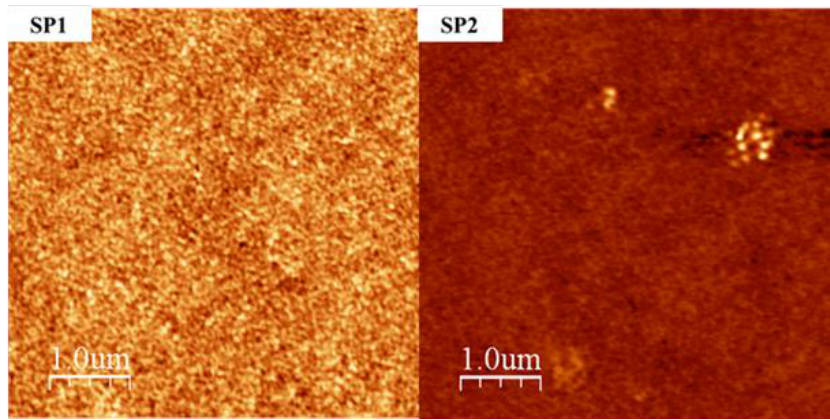
Figure 2. The scanning probe microscope (SPM) images of diphenylacridine (SP1) and phenothiazine (SP2).